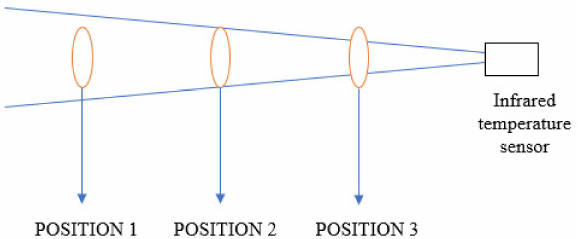
Figure 12. Schematic diagram of the relationship between the measured object and the field of view of the infrared temperature measurement system.